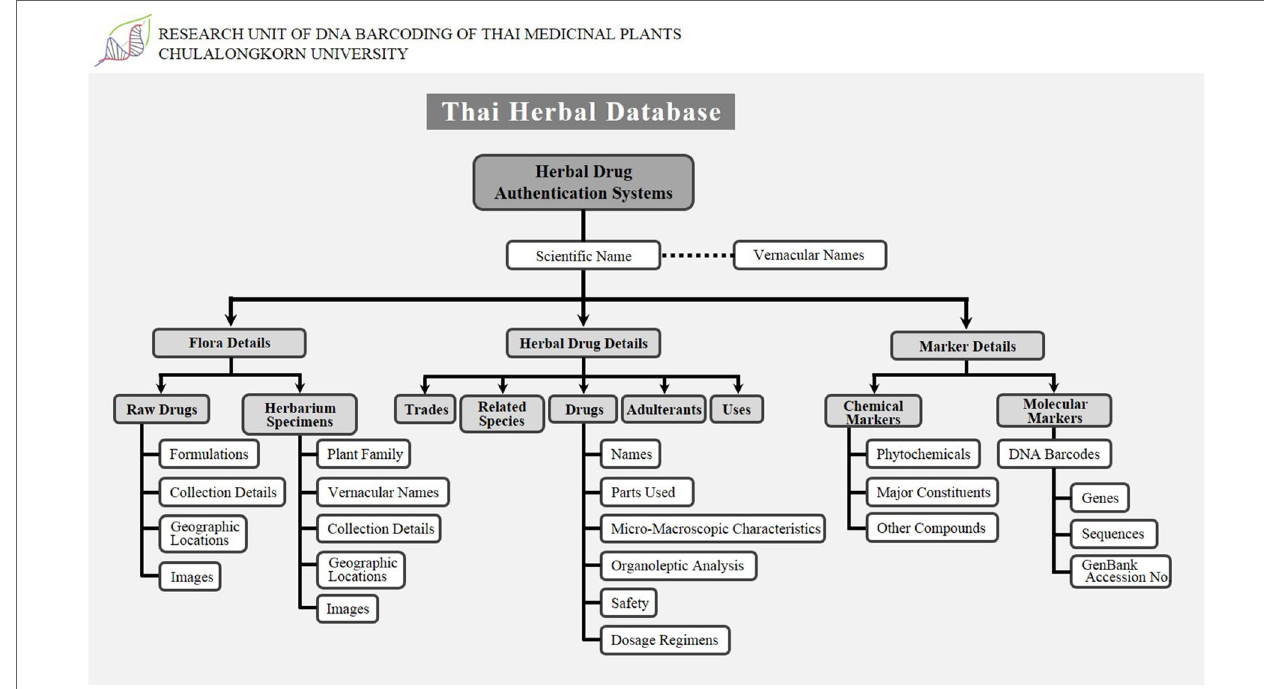
FIGURe 2 | Schematic representation of the Thai Herbal